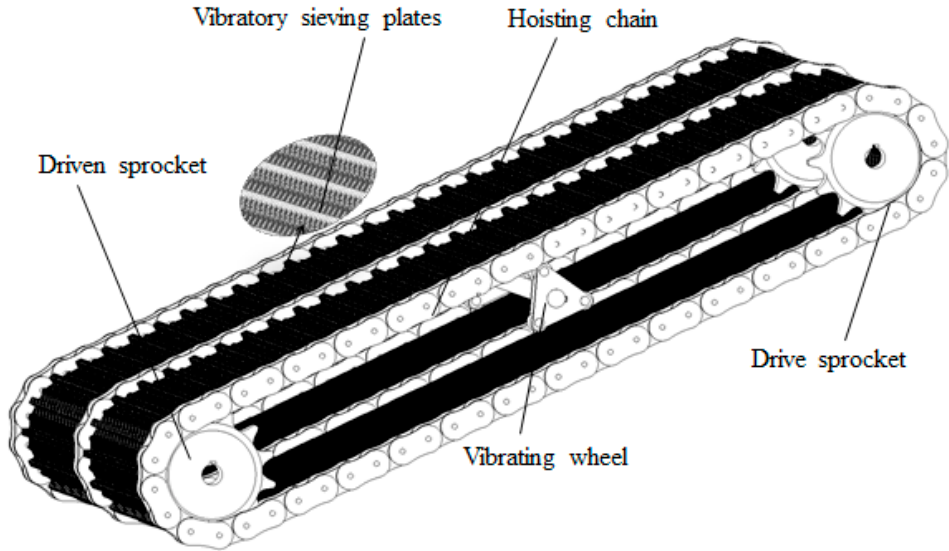
Figure 2. Combined rod-type hoisting sieve.